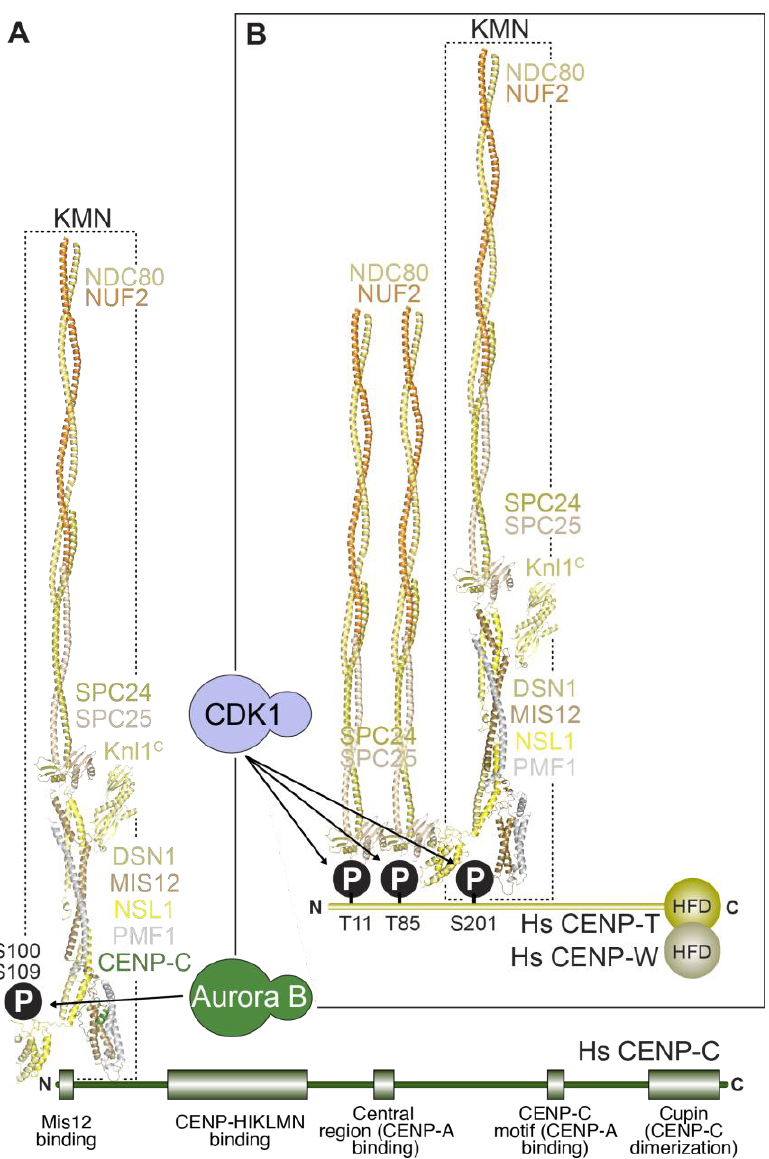
Figure 6. Linkages between the inner and outer kinetochore. Structures of a portion of the NDC80 complex (the N-terminal globular domains of NDC80 and NUF2 are not shown), the MIS12 complex and the C-terminal kinetochore-targeting domain of KNL1 are used to depict a KMN particle in humans. ( A ) The first linkage is formed by the interaction of a KMN particle with the N-terminal region of CENP-C. This interaction is enhanced by Aurora B phosphorylation of residues (S100 and S109) in the N-terminal region of the DSN1 subunit of the MIS12 complex; ( B ) The second linkage involves the interaction of up to two NDC80 complexes with two CDK1-phosphorylated residues (T11 & T85) in the N-terminal region of CENP-T, as well as of a second entire KMN recruited via a CDK1-dependent interaction of the MIS12 complex with S201 of CENP-T [239]. In vitro, CENP-C and CENP-T bind to the MIS12 complex within the KMN network competitively, implying that they cannot be bound to the same KMN [239]. All structures shown are for the human complexes.